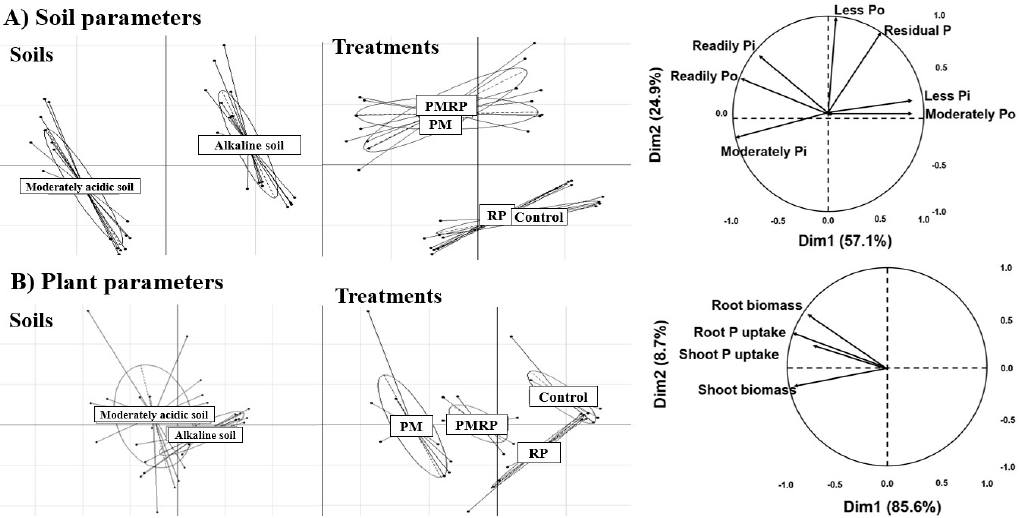
Figure 4. Principal component analysis of soil P forms ( A ) and plant ( B ) variables studied as the response to different soil types and treatments.